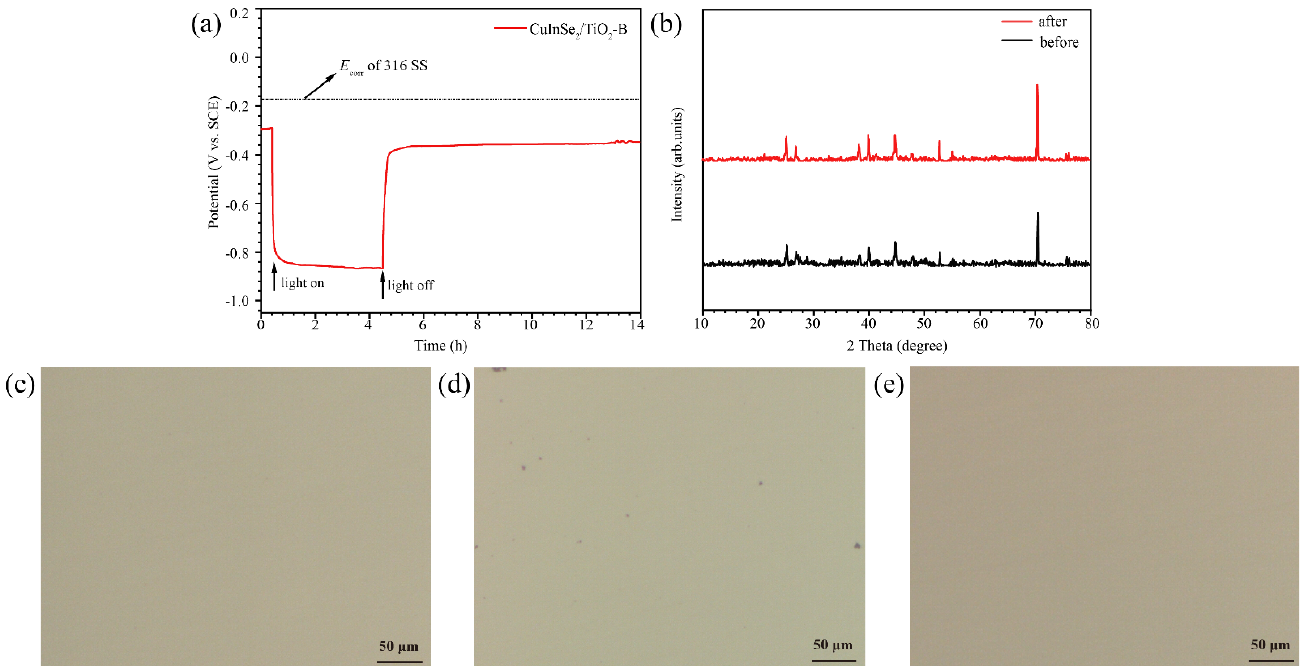
Figure 9. ( a ) Long ‐ term OCP change of 316 SS connected to the CuInSe 2 /TiO 2 ‐ B photoanode under on and off visible light illumination; ( b ) XRD images of CuInSe 2 /TiO 2 ‐ B before and after long ‐ term OCP measurements; the optical images of the 316 SS ( c ) before the experiment, ( d ) unprotected and ( e ) protected by CuInSe 2 /TiO 2 ‐ B for 14 h.